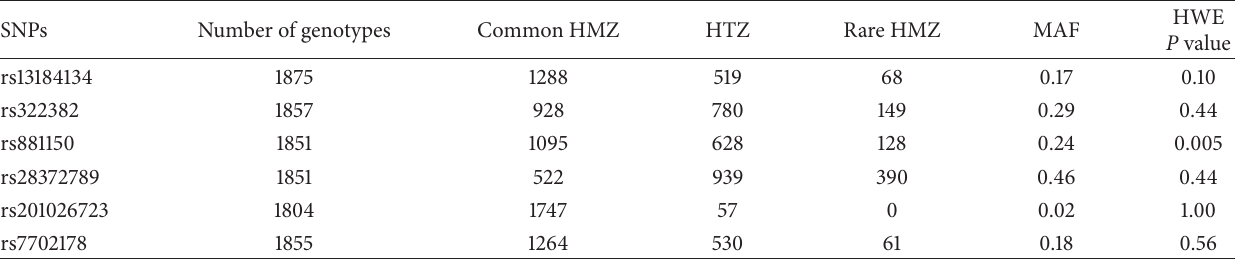
Table 3: Genotype distribution of selected